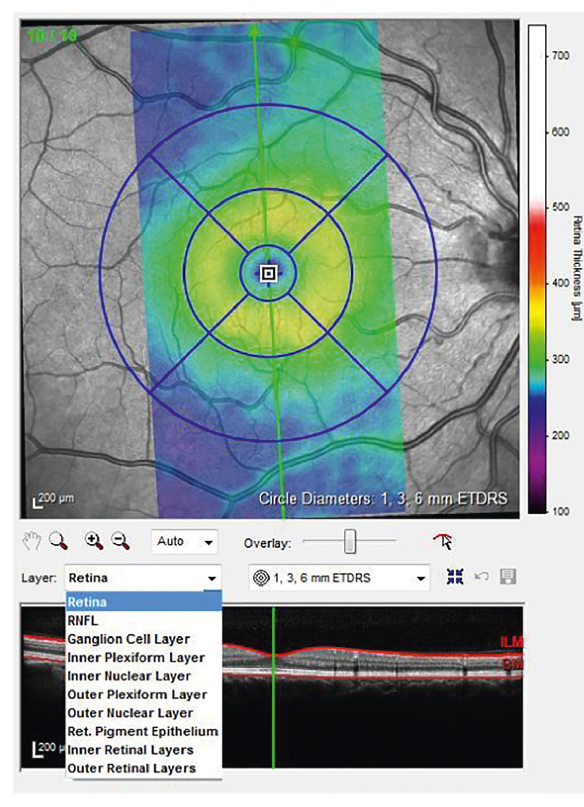
Figure 2: Sample of segmentation of retinal